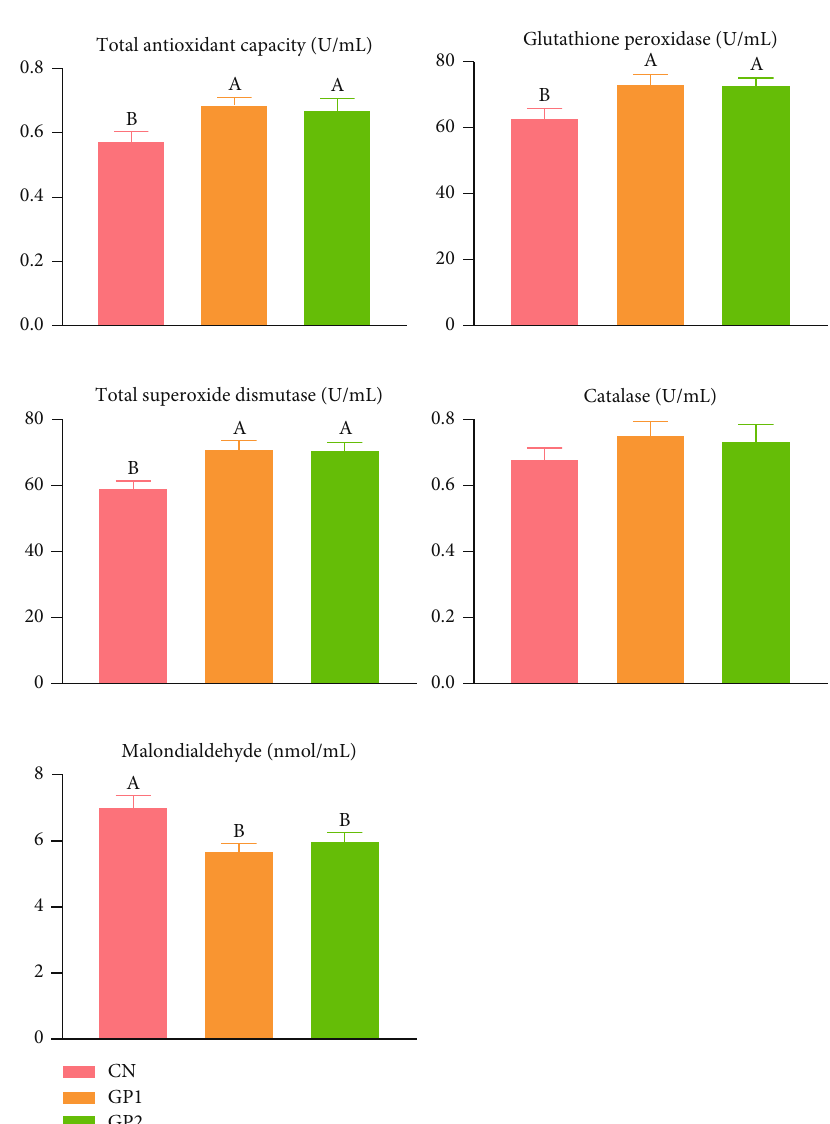
Figure 3: E ff ects of garlic powder inclusion on the antioxidant status of hepatopancreas in Chinese mitten crabs. Bars assigned with di ff erent superscripts are signi fi cantly di ff erent ( P < 0 : 05 ); CN represents the control group that Chinese mitten crabs fed a basic diet; GP2 represents the group that the Chinese mitten crabs fed with 1000 mg/kg garlic powder in addition to the basic diet; GP2 represents the group that the Chinese mitten crabs fed with 2000 mg/kg garlic powder in addition to the basic